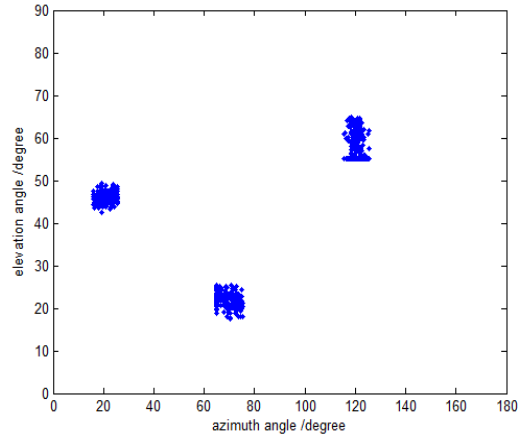
Figure 2. The coarse DOA estimation with fixed SNR 15 dB and snapshot number 500.